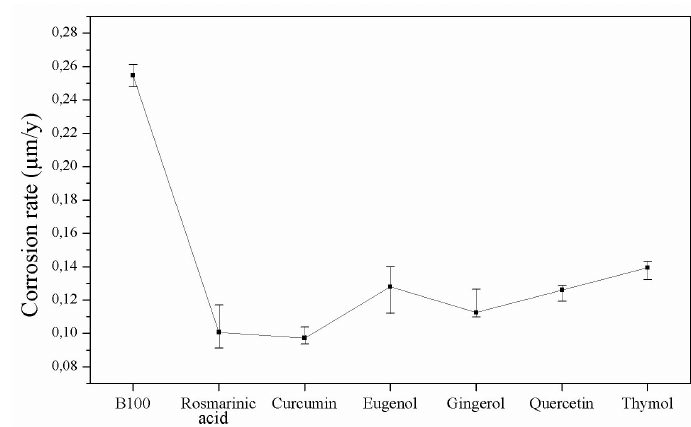
Figure 4. Corrosion rate of carbon steel in B100 in the absence and presence of 1000 ppm of different additives.